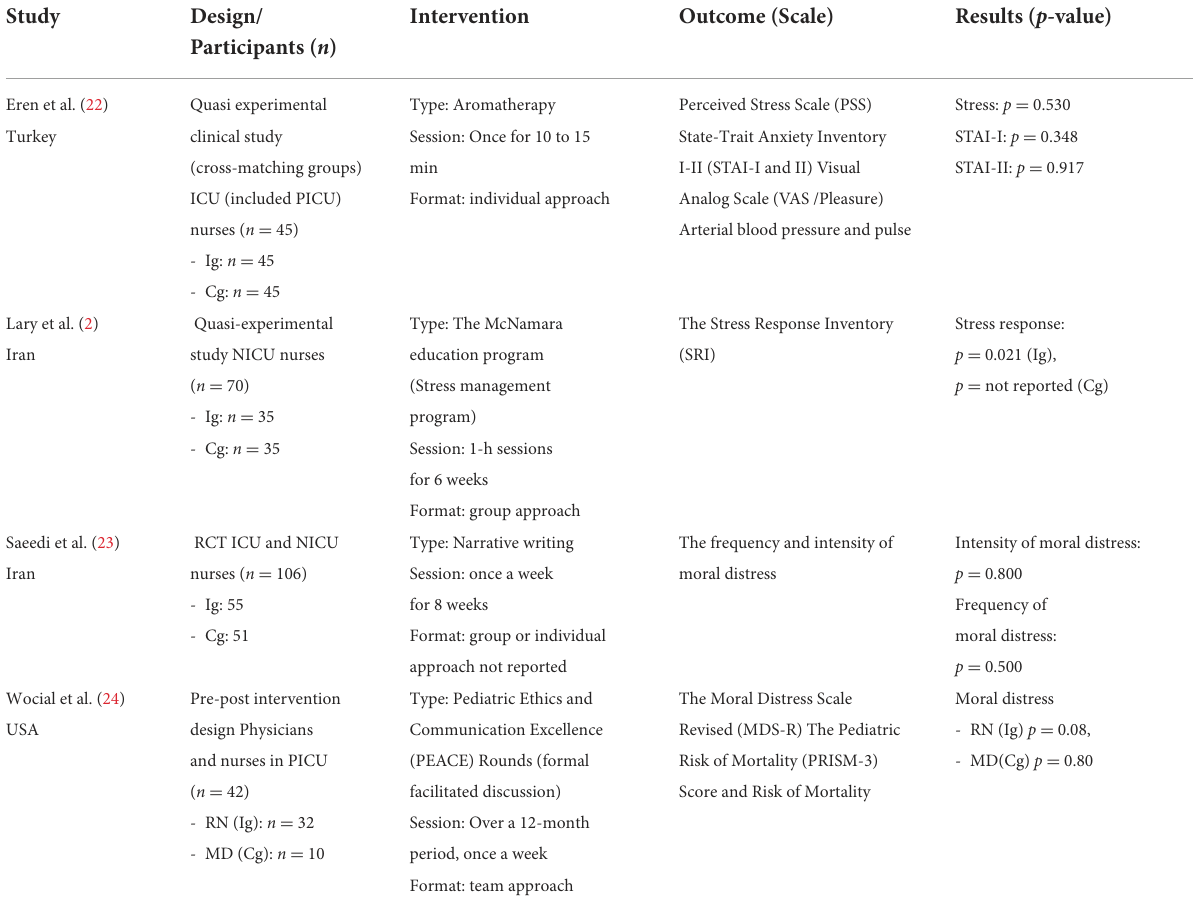
TABLE 1 Descriptive summary of included